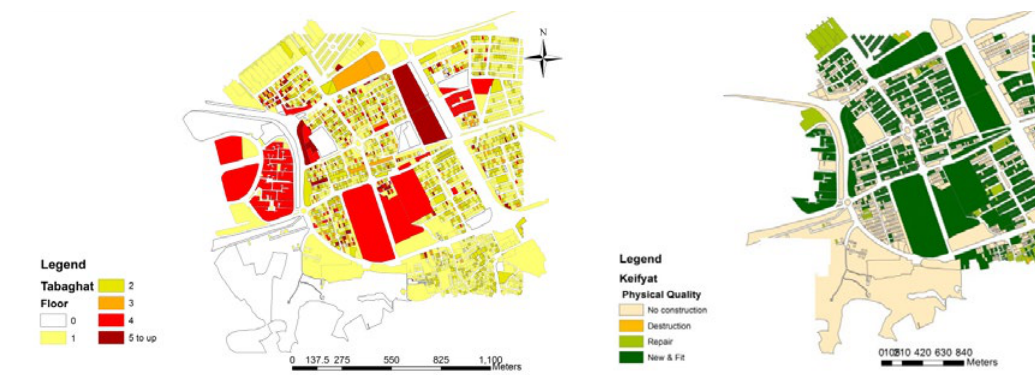
Fig. 5: Floor Density in study area